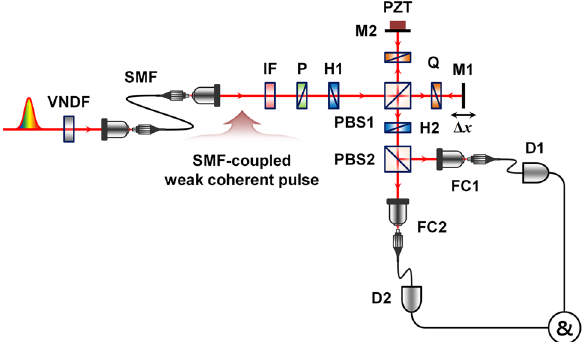
Figure 4. Experimental setup to observe the two-photon interference of weak coherent pulses. VNDF, variable neutral density filter; IF, interference filter; P, linear polarizer; H, half-wave plate; Q, quarter-wave plate; PBS, polarizing beam splitter; M, mirror; PZT, piezoelectric transducer; FC, Single-mode fiber coupler; D, single- photon detector; & coincidence counting circuit. (cid:31) x refers to the path-length difference between the two interferometer arms.